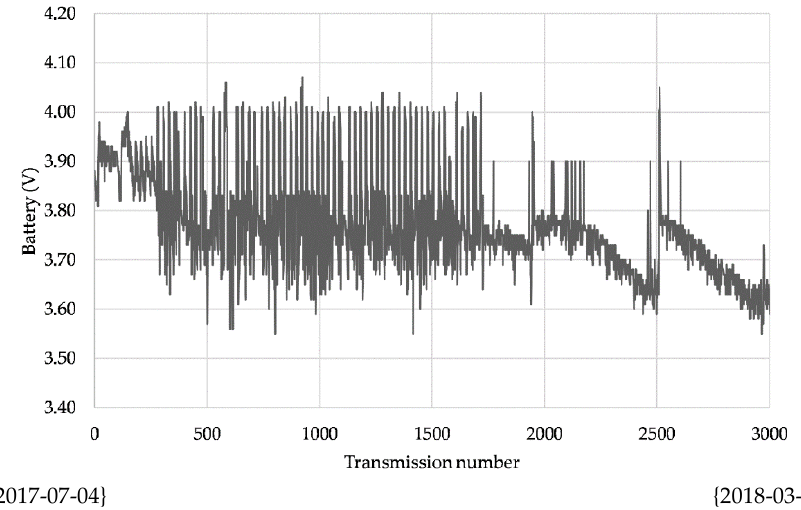
Figure 17. Example of application: battery level data on a node sampled by the microcontroller.